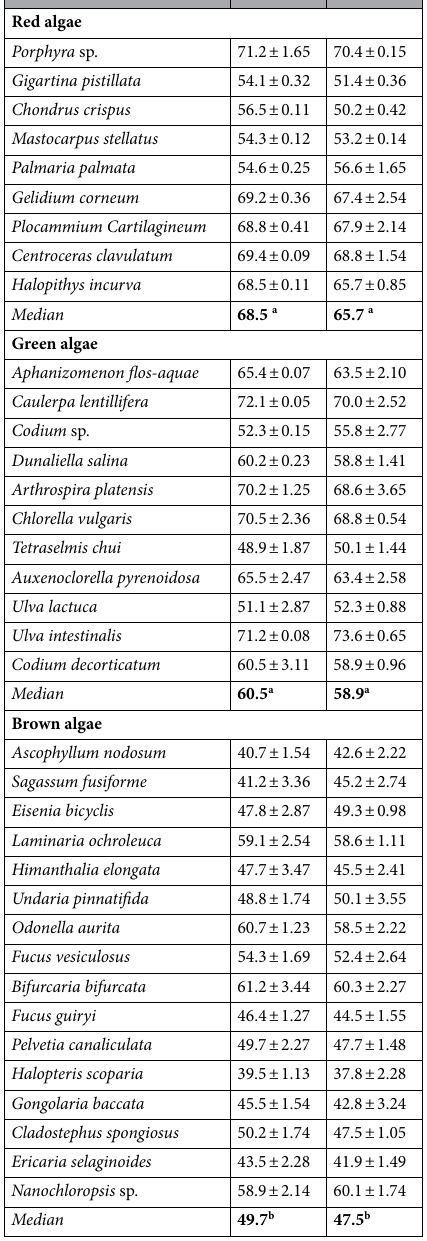
Table 3. Antioxidant (TEAC, DPPH) activities in enzymatic protein hydrolysates (EPHs) from the algae samples (mean of n = 3 independent determinations ± SD). Significant values are in bold. Different small letters in the same column indicate significant differences between medians of the algae groups ( p <